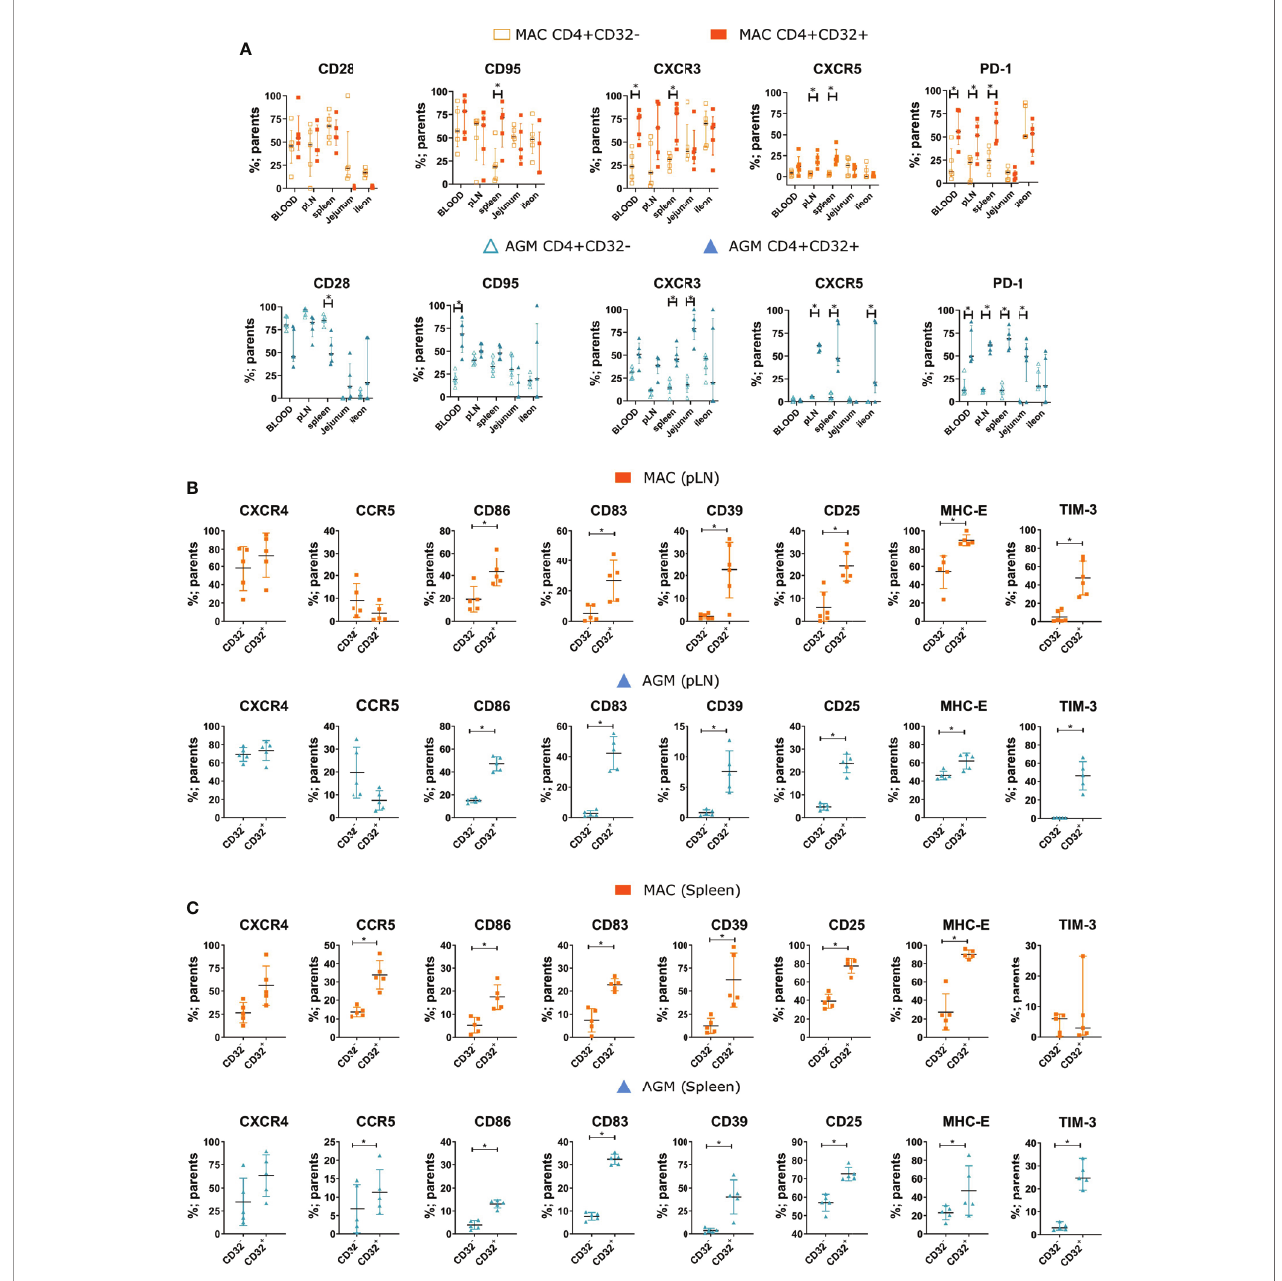
FIGURE 3 | Phenotypic characterization of CD32+CD4+ T cells in tissues during SIV infection. (A) Frequencies of the indicated marker on CD32 - (empty symbols) and CD32+ (full symbols) for CD4+ T cells from different tissues during chronic SIV infection in MAC (orange) and AGM (blue). (B, C) Frequency of CD32 - and CD32+CD4+ T cells expressing a given marker in (B) peripheral LN (pLN) and (C) spleen during chronic SIV infection in MAC (orange) and AGM (blue). Each symbol represents a single animal (N=5 animals for each species). In (A) , two-way ANOVA with Sidak test for multiple comparisons was performed. In (B, C) , statistical difference was assessed by a Mann-Whitney U-test. Asterisks indicate p-values <